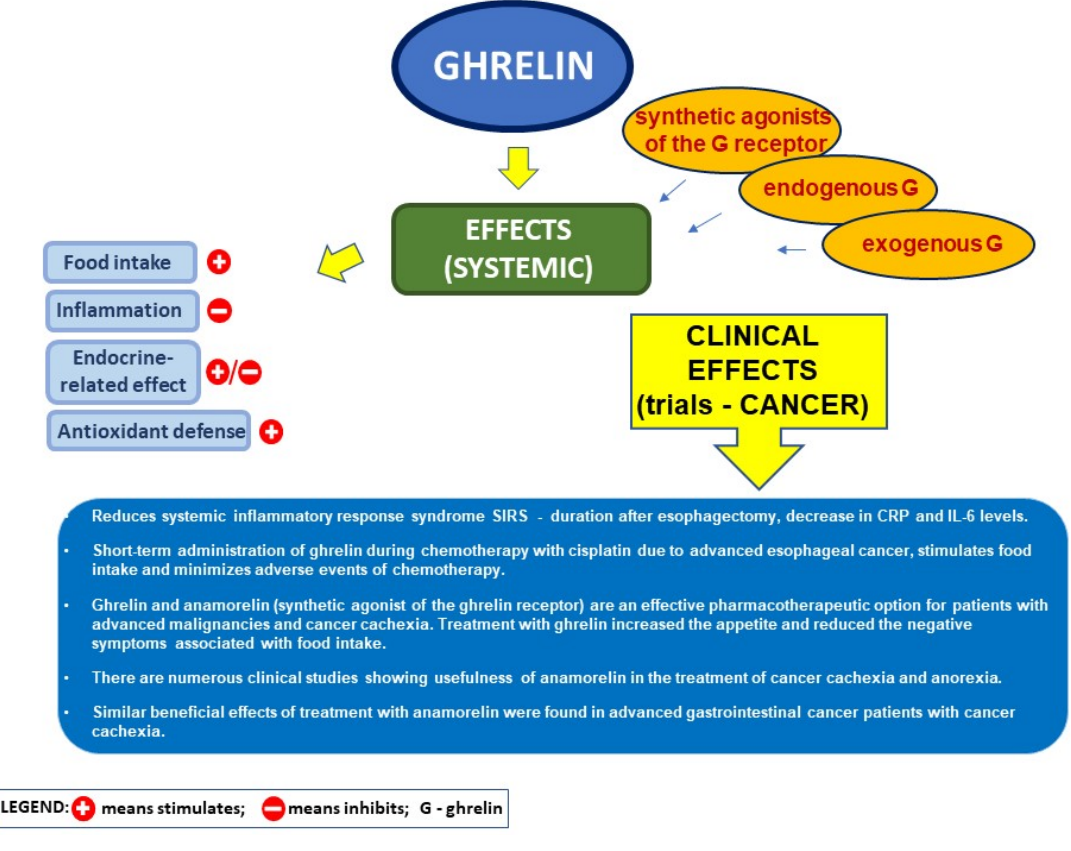
Figure 3. Supportive effect of ghrelin in cancer disease.